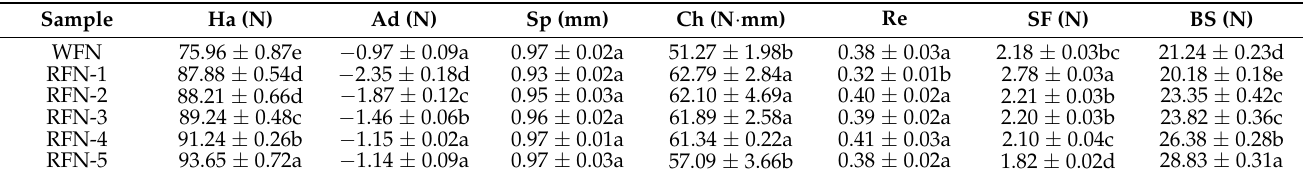
Table 5. Effect of highland barley flour with different particle sizes on the texture properties of noodles.